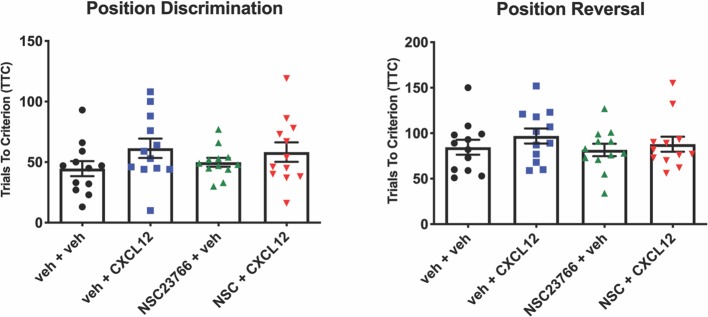
NSC23766 treatment did not alter performance on position discrimination or position reversal in WT rats.There were no significant differences among all groups during the first two phases of the behavioral task. N=12 animals/group.